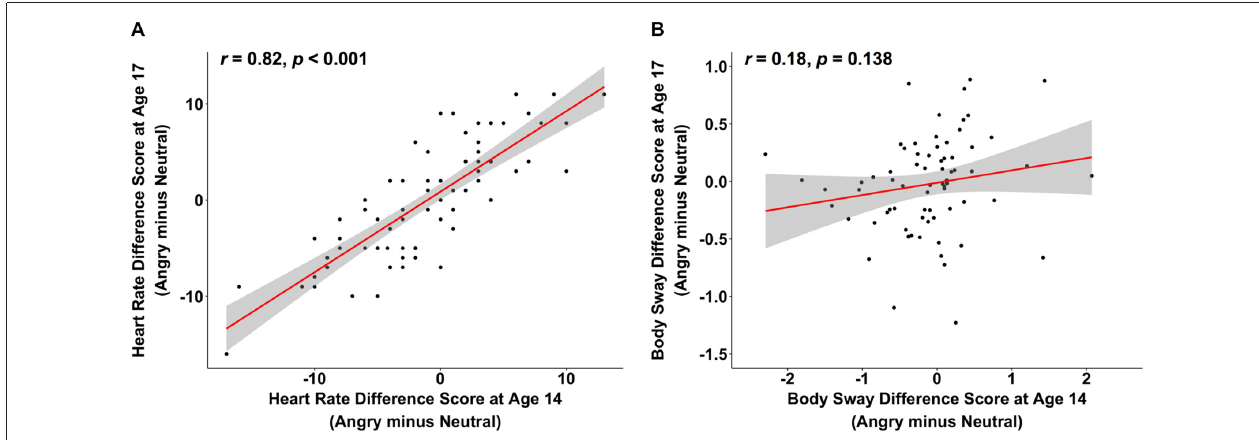
FIGURE 1 | The scatterplots (with best-fitting regression line) illustrate the correlations between changes in heart rate variability (in beats per minute) at ages 14 and 17 (A) and between changes in body sway variability (in mm) at ages 14 and 17 (B) while participants were looking at angry compared to neutral faces. Three multivariate outliers were excluded for the correlations in (A,B) .